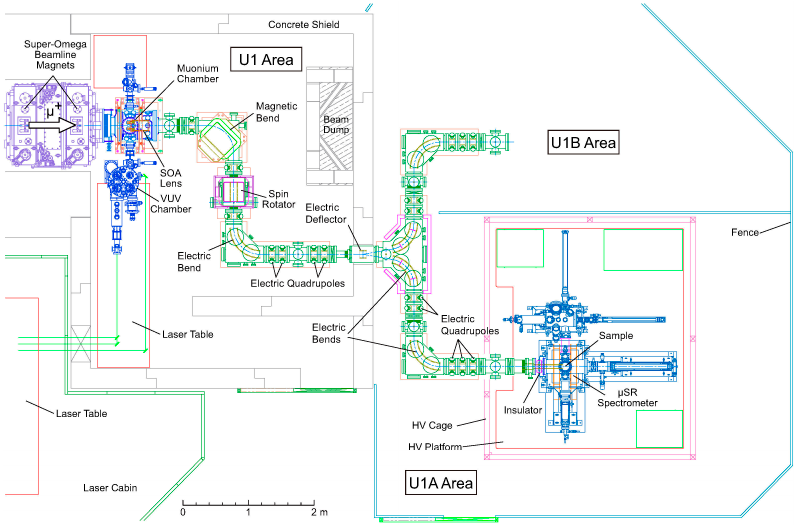
Figure 8. Layout of the ultra-slow muon (USM) beamline. A high-flux surface muon beam is injected into a hot W target in the muonium chamber (left), from which thermal muonium atoms evaporate into a vacuum. These muonium atoms are ionized by a laser system and accelerated and focused by an electrostatic lens for transport at 30 keV. The transport beamline consists of one magnet bend, three electric bends, and electric quadrupoles, and it is electrostatically isolated from the high-voltage cage accommodating the muon spin rotation ( µ SR)